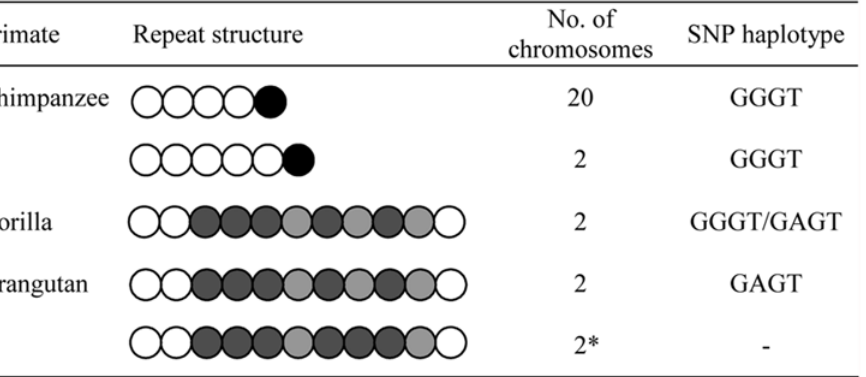
Figure 3. Repeat Structure and Haplotype in non-Human Primates. Open circles represent ATTCT repeats; black circles represent ATTTAT repeats; light gray circles represent GTTCT repeats and dark gray circles represent GTTCC repeats; * Repeat structure from the Orangutan